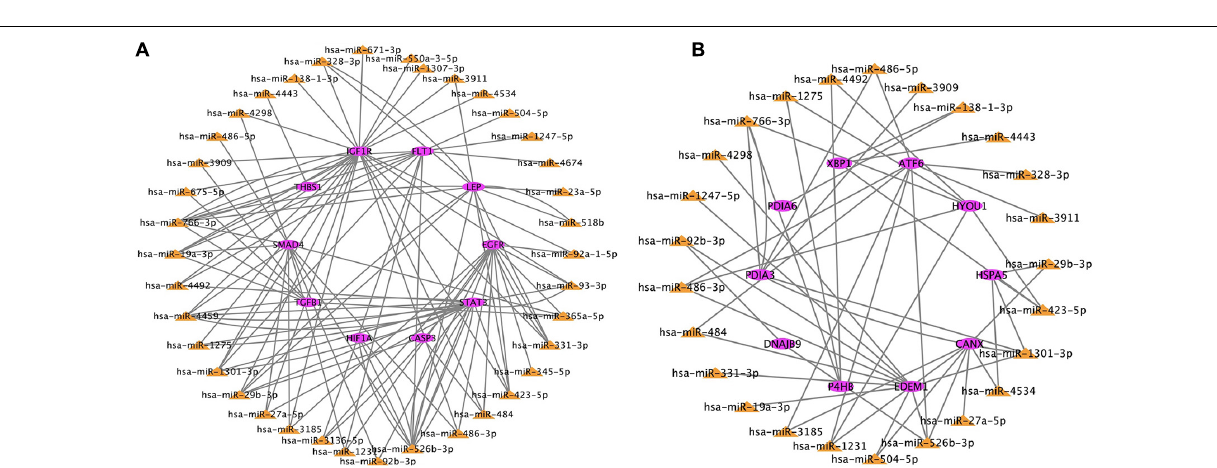
FIGURE 7 | Regulatory network of miRNAs and mRNAs for candidate genes related to (A) hypoxia and (B) endoplasmic reticulum. The color frame represents the attribute. Pink = mRNA. Yellow =